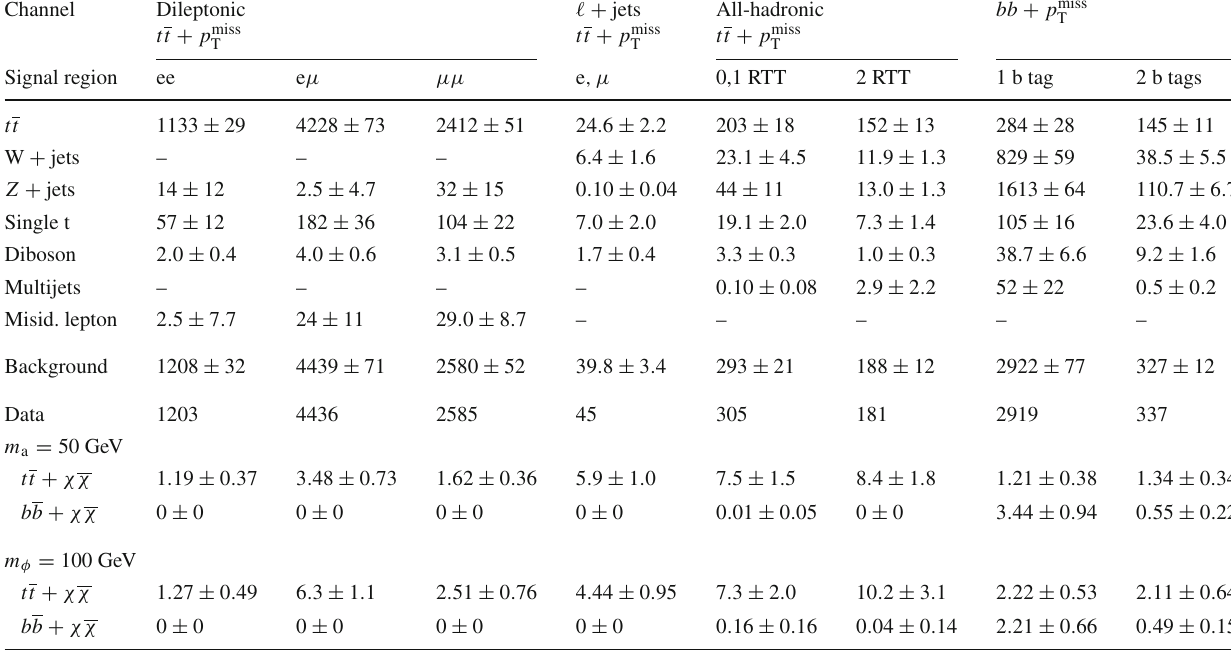
Table 4 Fitted background yields for a background-only hypothesis in m a = 50 GeV and a scalar mediator with mass m φ = 100 GeV are also the tt + p miss shown. Mediator couplings are set to g q = g χ = 1, and a DM particle and bb + p miss signalregions.Theyieldsareobtainedfrom T T of mass m χ = 1 GeV is assumed. Uncertainties include both statistical separate fits to the bb + p miss and individual tt + p miss search channels. T T and systematic Prefit yields for DM produced via a pseudoscalar mediator with mass